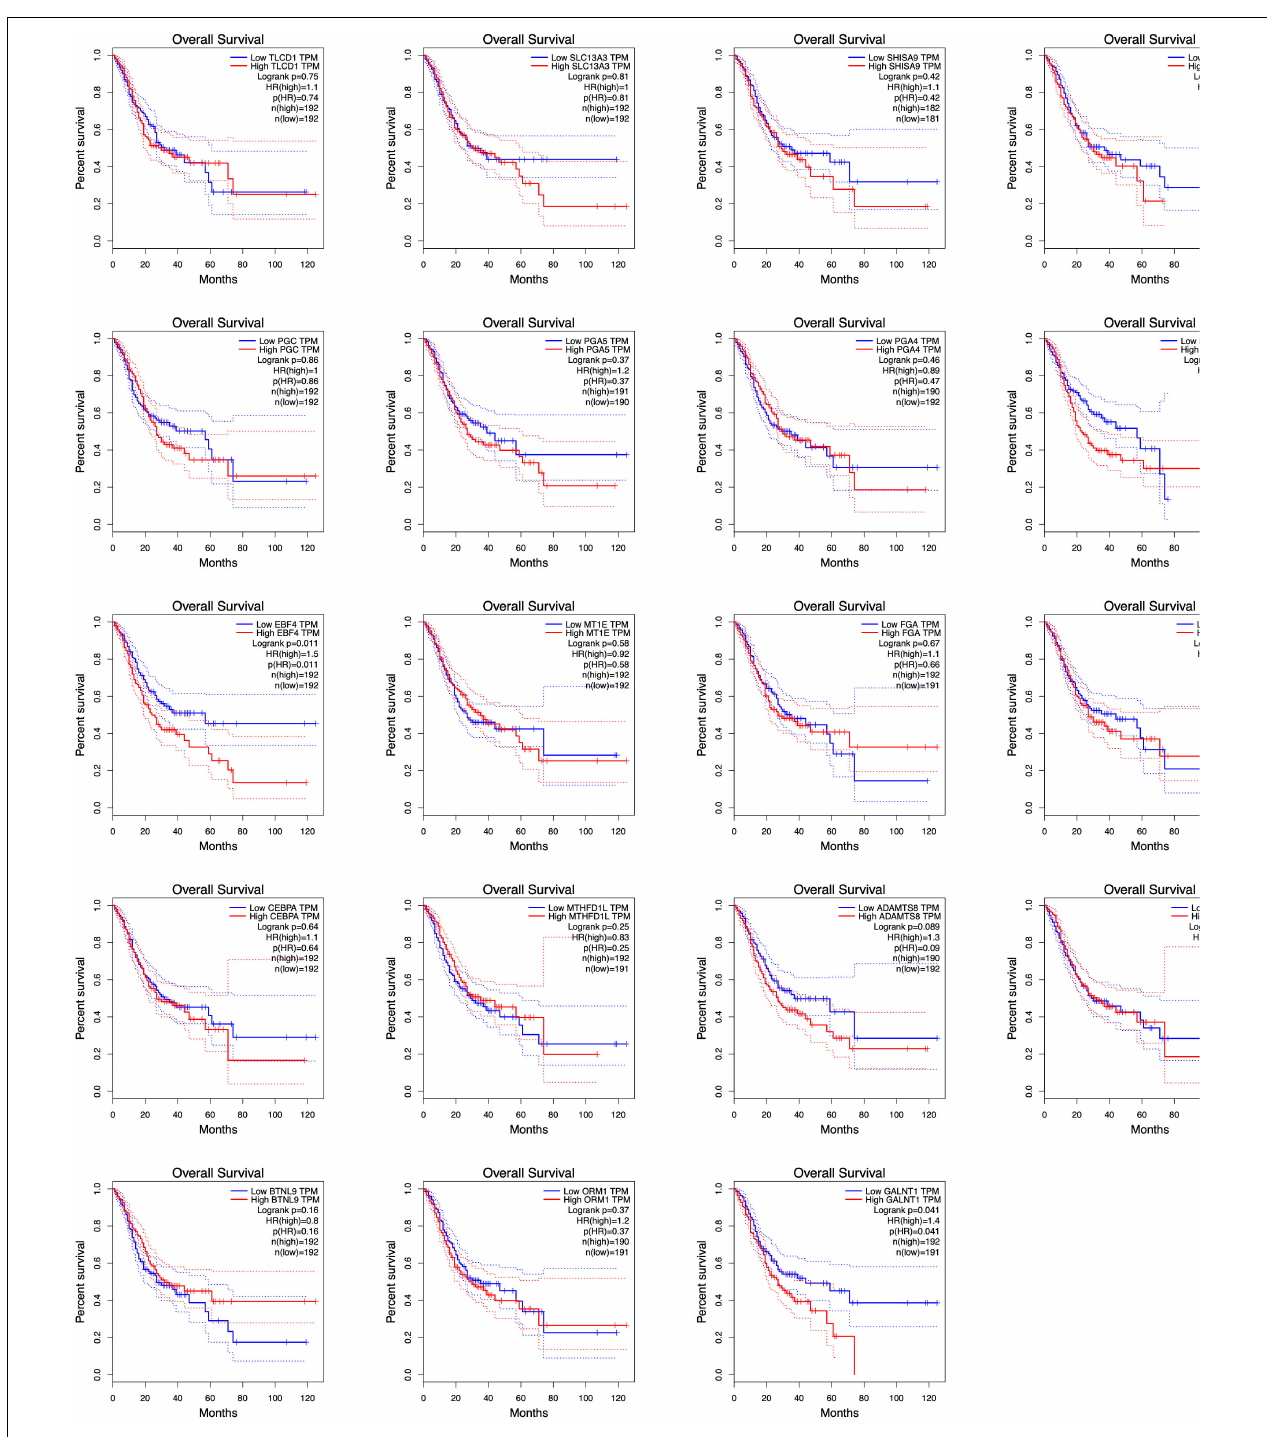
FIGURE 9 | Survival analyses of hub genes by TCGA data. GNLAT1, EBF4, F13A1, and NLGN1 expression levels were related to the overall survival ( P < 0.05).